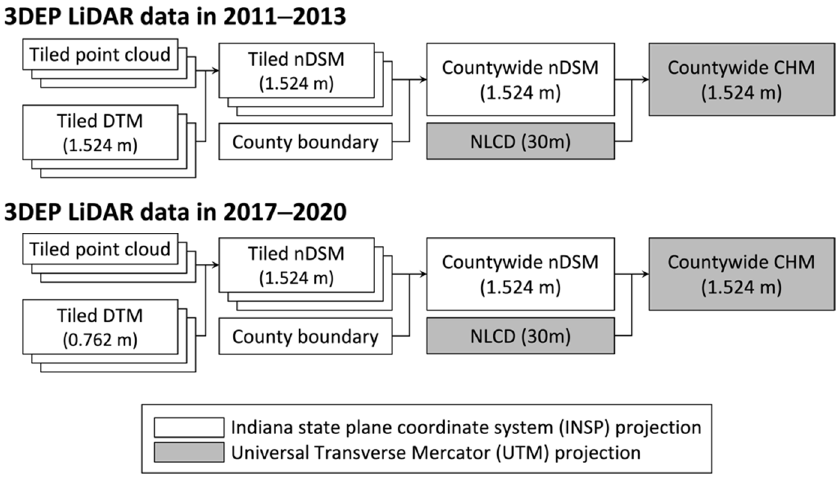
Figure 5. A workflow to generate countywide canopy height models (CHM) using 3D Elevation Program (3DEP) LiDAR data.